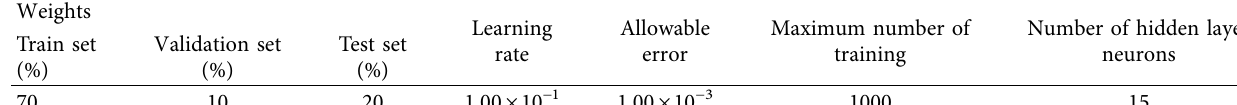
Table 1: Important parameters of the BP network learning process.